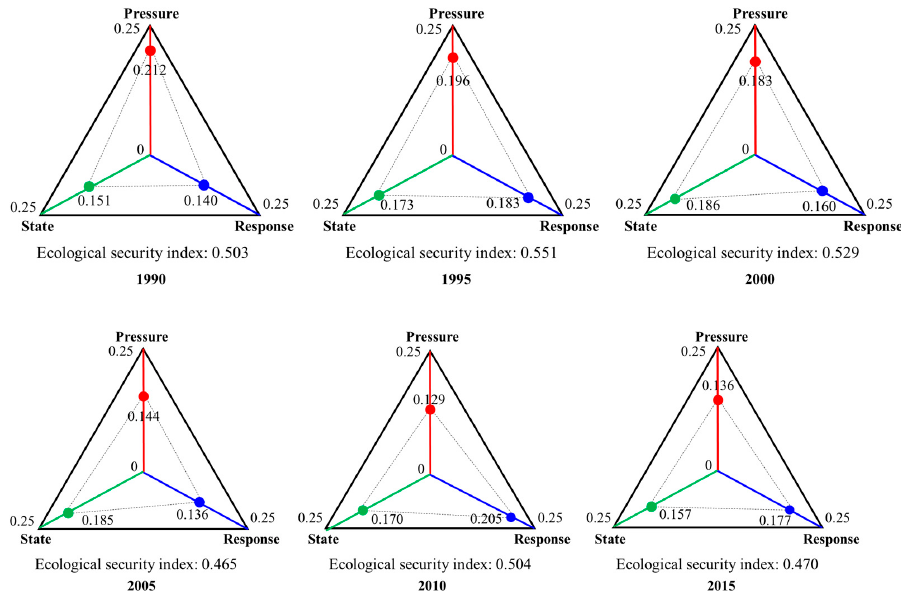
Figure 3. Change trends of ecological security, pressure, state, and response index in the Pearl River Delta from 1990 to 2015.